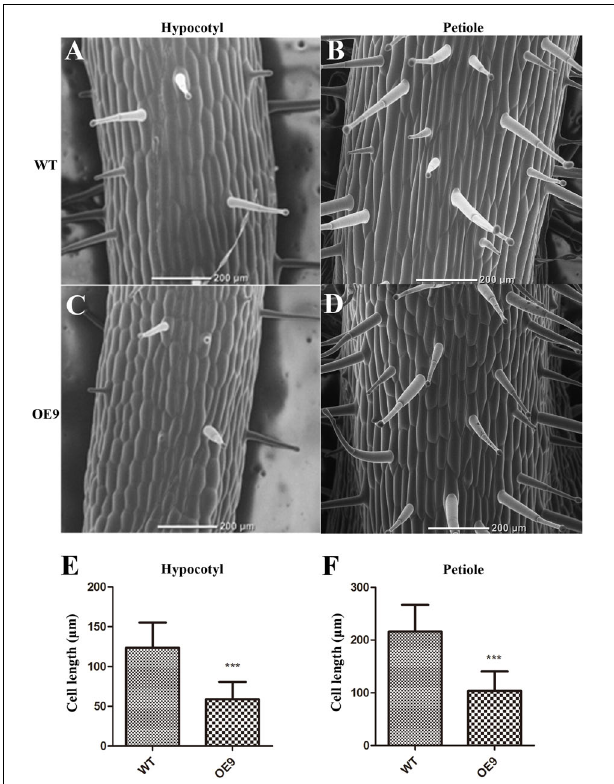
FIGURE 6 | Scanning electron microscope observation and the statistics of cell length of the hypocotyls and petioles. (A,C) Indicated the cell morphology of hypocotyls of the two-leaf-stage plants. (B,D) Indicated cell morphology of the second petioles of the four-leaf-stage plants. The average cell length of the hypocotyls (E) and petioles (F) were calculated. OE9 possessed shorter cells in both hypocotyl and petiole. For (E) and (F) , the values represent the mean ± SD of the data from at least 40 cells of two different hypocotyls and petioles and the statistically significant differences were evaluated by Student’s t -test ( ∗∗∗ P -value <